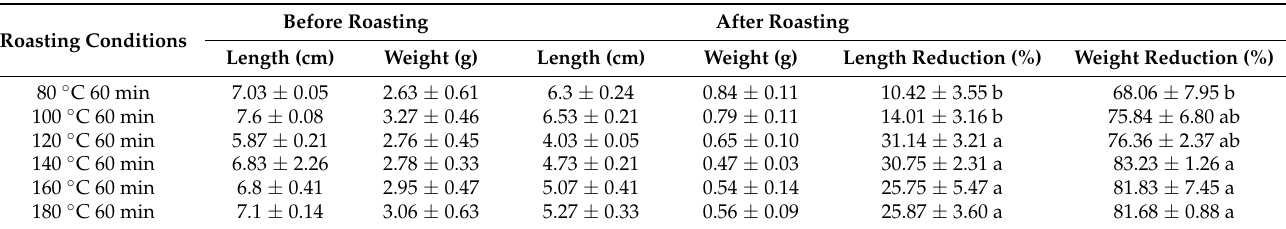
Table 1. Samples included in this study.